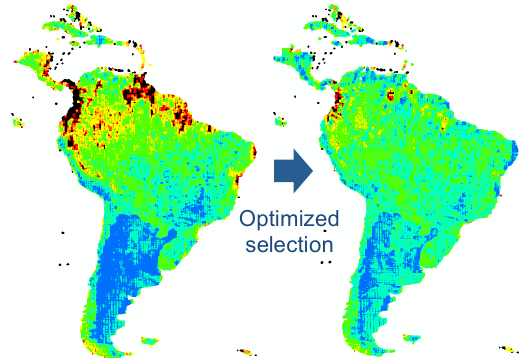
Figure 4. SPOT 6/7 optimized archive selection with respect to cloud cover and acquisition attributes. Left: initial selection with less than 15% cloud cover over the image. Right: optimized selection with a relaxed cloud cover constraint in low overlap count areas and redundant image removal. Colour range same as previous figure.